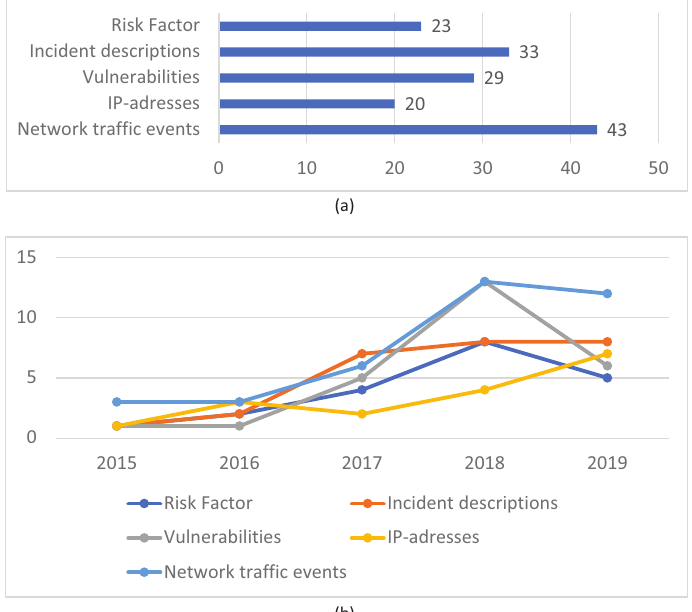
Figure 9. ( a ) Data content categories addressed by 20 or more primary studies; and ( b ) number of primary studies addressing data content categories in the